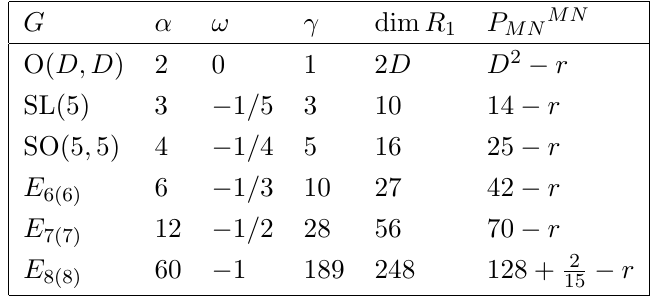
Table 2 . Constants appearing in the projector. Here (cid:13) (cid:17) Y MN MN = dim R 1 and r is de(cid:12)ned in (2.7). For the usual cosets r = 0 for all cases except E One (cid:12)nds, as summarised in table 2, that for all groups except E jector gives exactly the dimension of the usual G=H coset minus r . For E